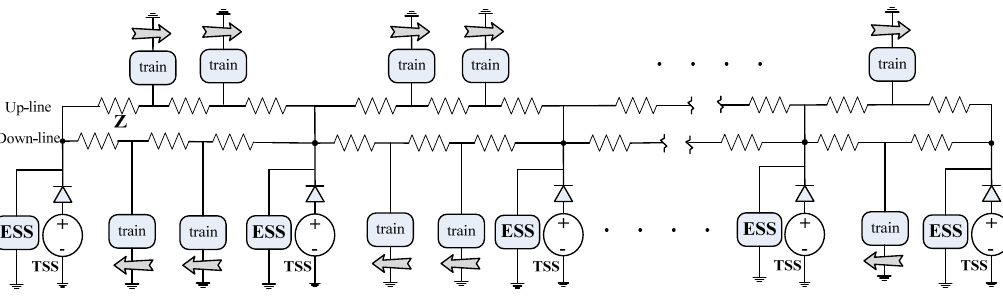
Figure 1. The model of metro system’s DC traction power supply network.